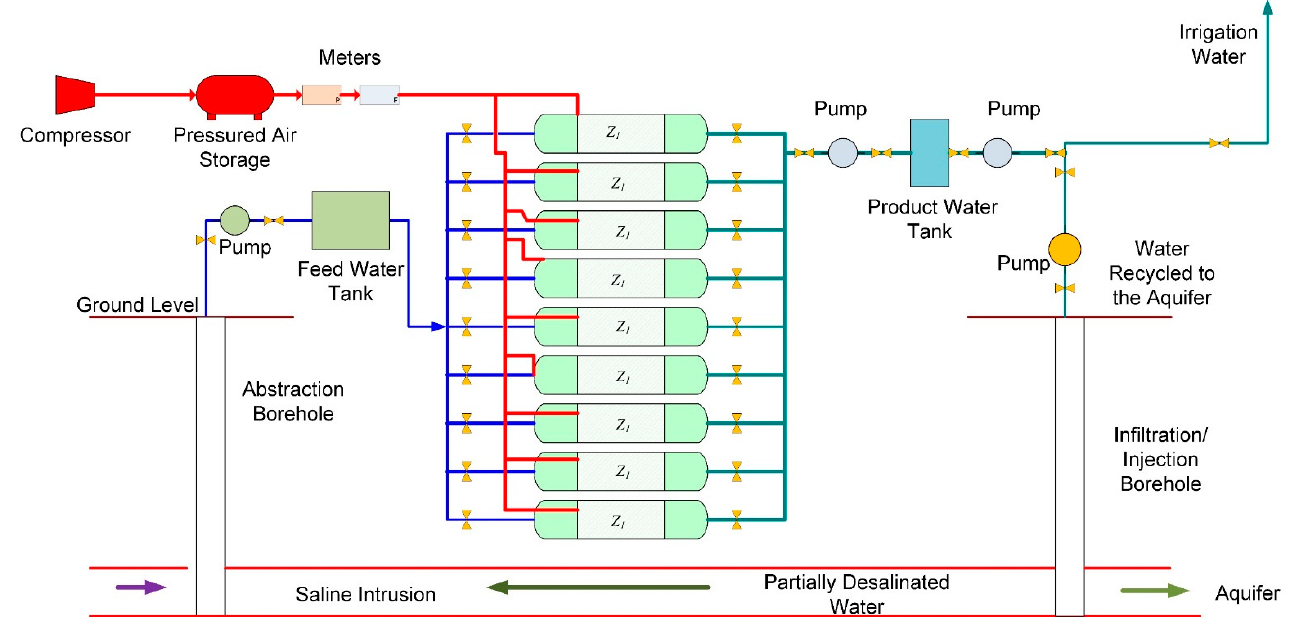
Figure 23. Process flow diagram for a multi ‐ train reactor processing abstracted saline water. Gas flow lines are coloured red. Saline feed water flow lines are coloured blue. Product water (partially desalinated water) flow lines are coloured green. Z i = reactor containing ZVI.